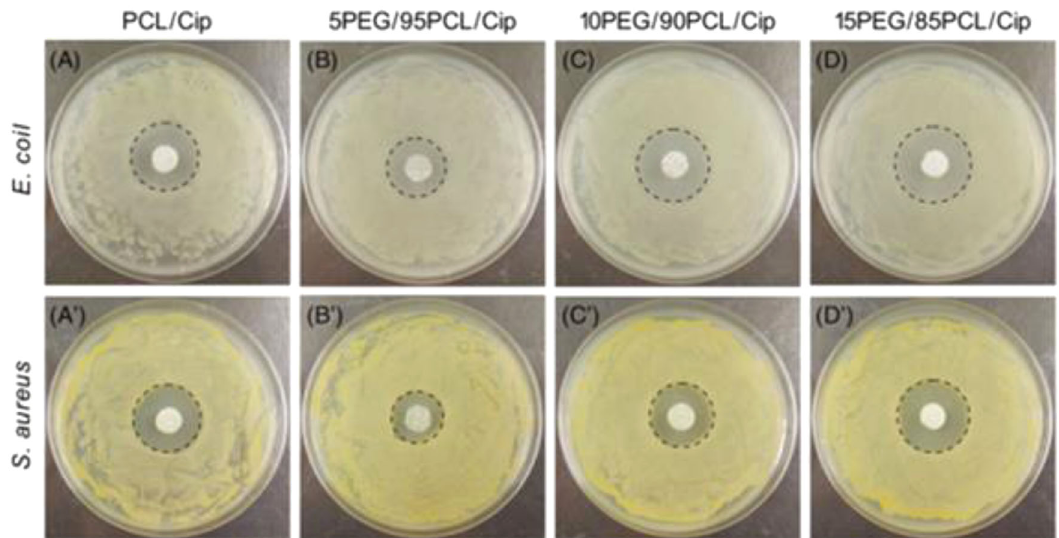
Fig. 10 A – D, Bacteria (Escherichia coli) inhibition zone of fi ber mats with different component ratios on agar plates; A ′ – D ′ , Bacteria (Staphy- lococcus aureus) inhibition zone of fi ber mats with different component ratios on agar plates